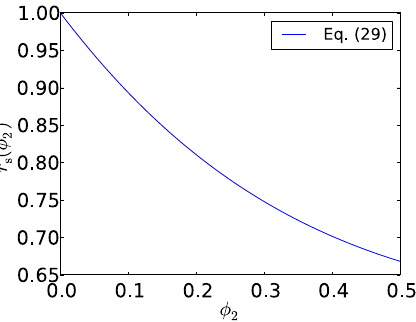
Figure 1. Ratio of scattering coefficient calculated with IBA and DMRT theory as a function of ice volume fraction φ 2 evaluated for ε 1 = 1 and ε 2 = 3.17 + 0.0022 i .